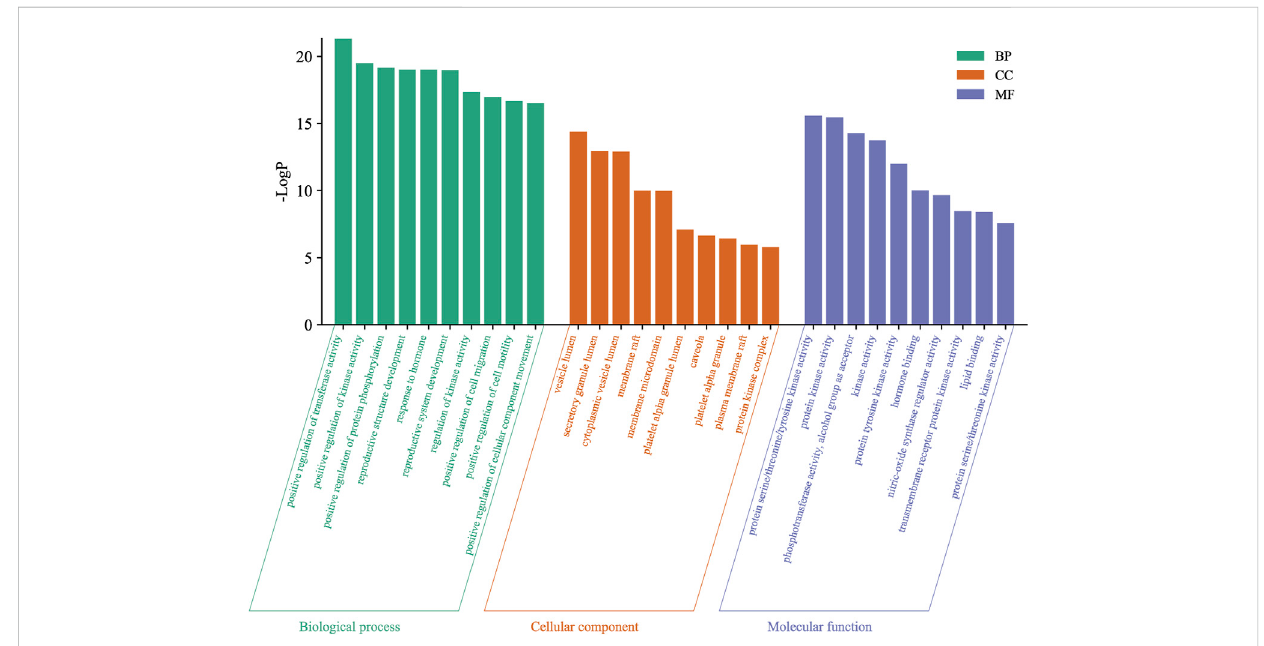
FIGURE 3 Visualization of Gene Ontology (GO) enrichment analysis. Biological process (BP), cellular component (CC), and molecular function (MF) of GO enrichment analysis are shown as green, orange, and purple bars, respectively.